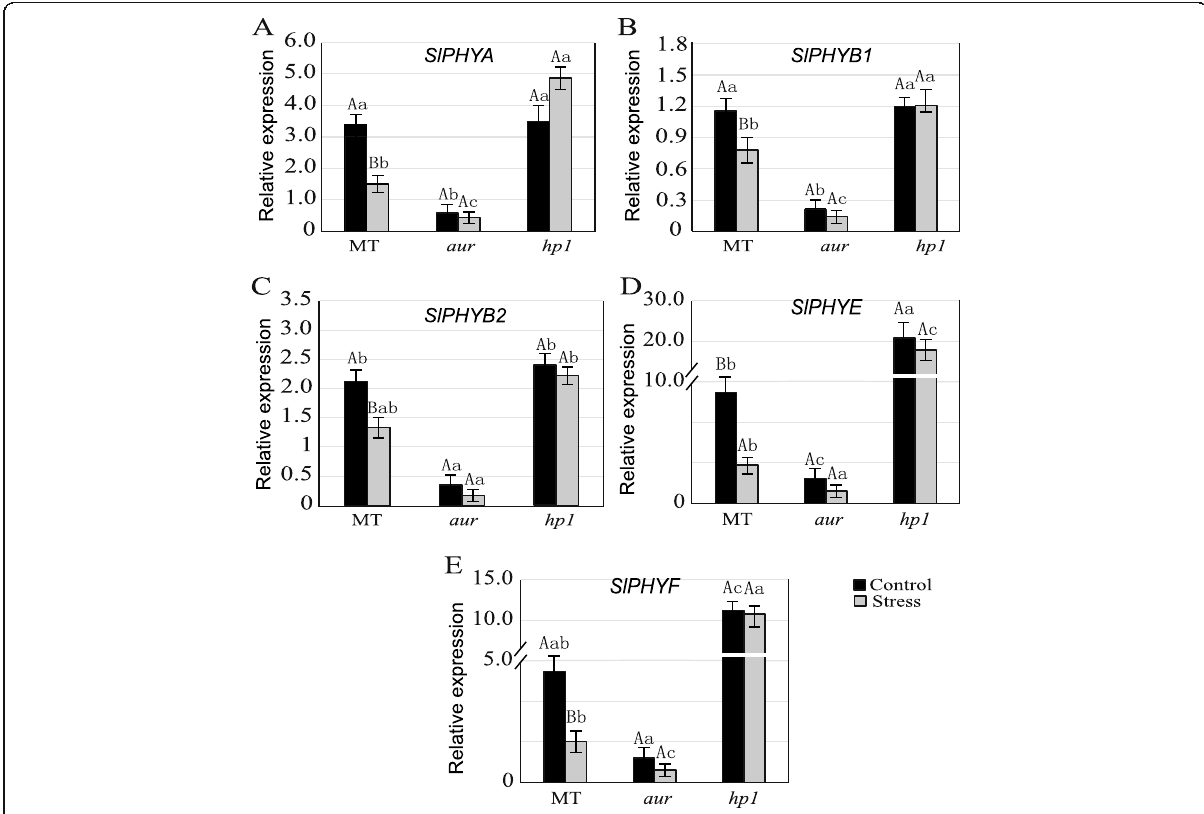
Fig. 8 Analysis of PHY genes in tomato mutants, aurea ( aur ) and high pigment1 ( hp1 ), and wild-type tomato (MT) under control and CS conditions. Transcript levels of all five known tomato PHY genes a SlPHYA , b SlPHYB1 , c SlPHYB2 , d SlPHYE , and e SlPHYF were examined in mutants and wild-type genotypes before and after chilling